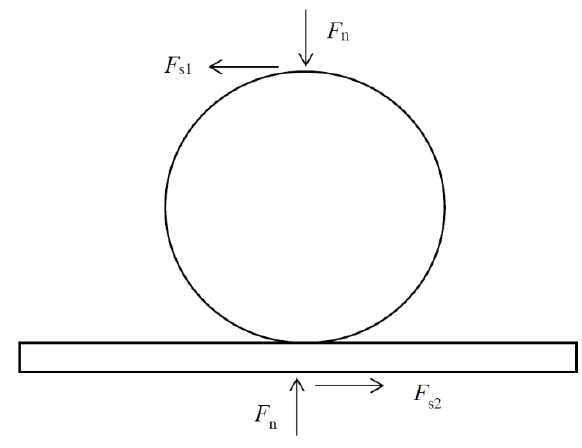
Figure 3. The forces acting on the proppant.